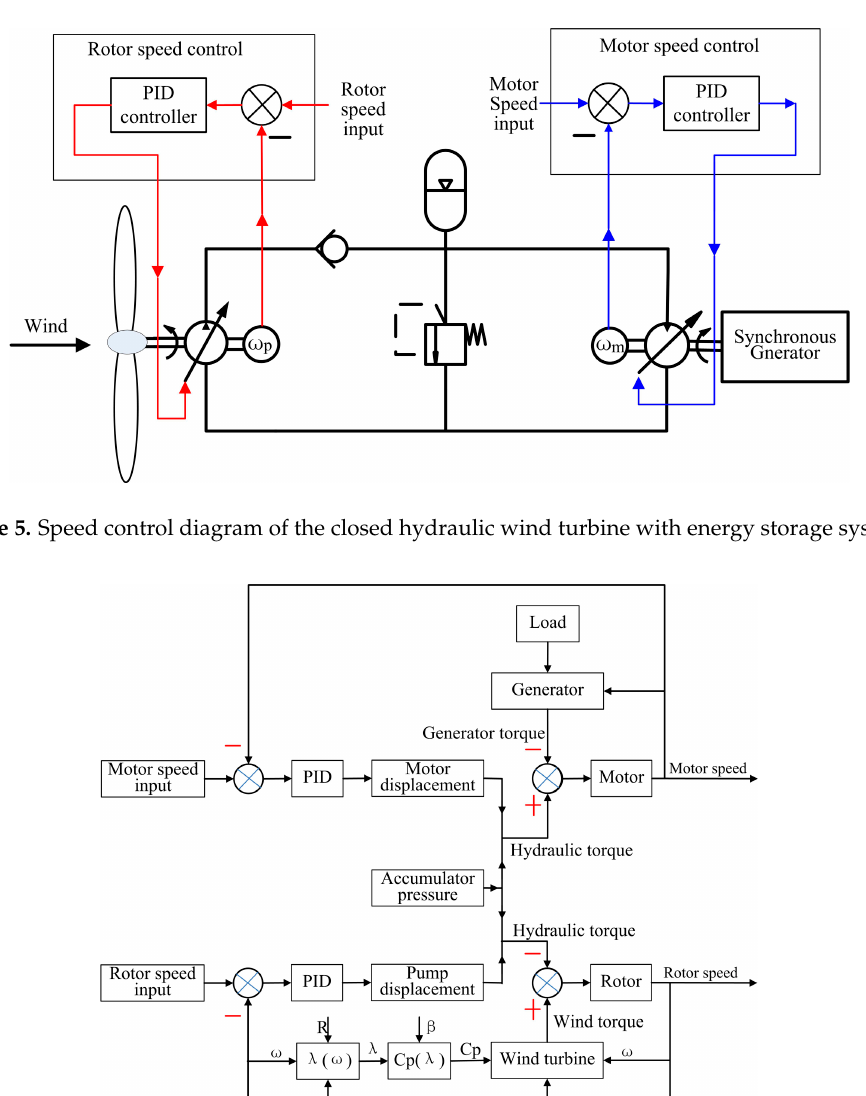
Figure 5. Speed control diagram of the closed hydraulic wind turbine with energy storage system.